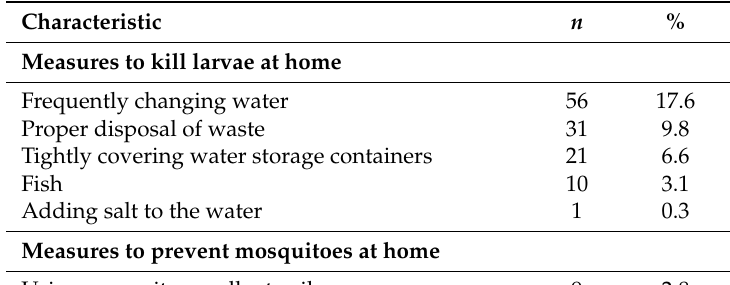
Table 5. Practice toward